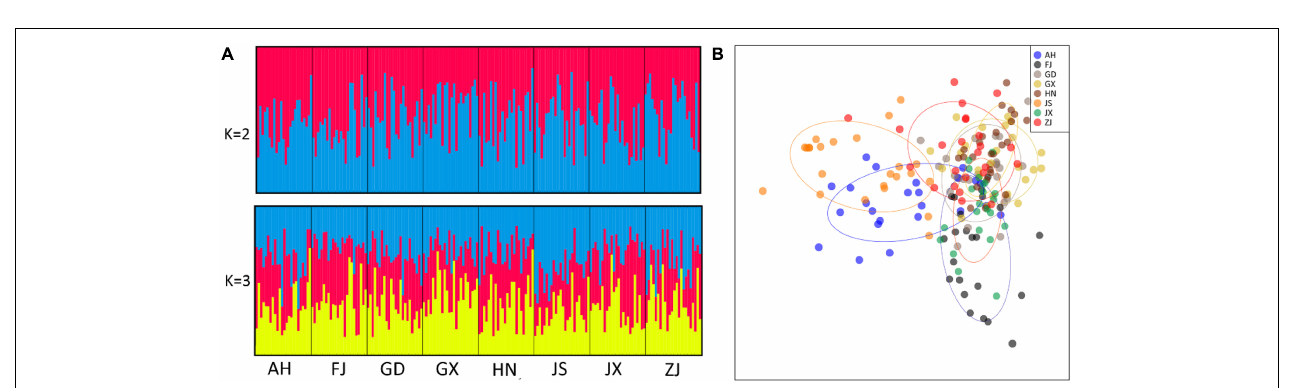
FIGURE 4 | Bayesian-inference phylogenetic relationships among mitochondrial cox1 haplotypes of Phyllotreta striolata worldwide. C, haplotypes present in China. A, haplotypes present outside China.